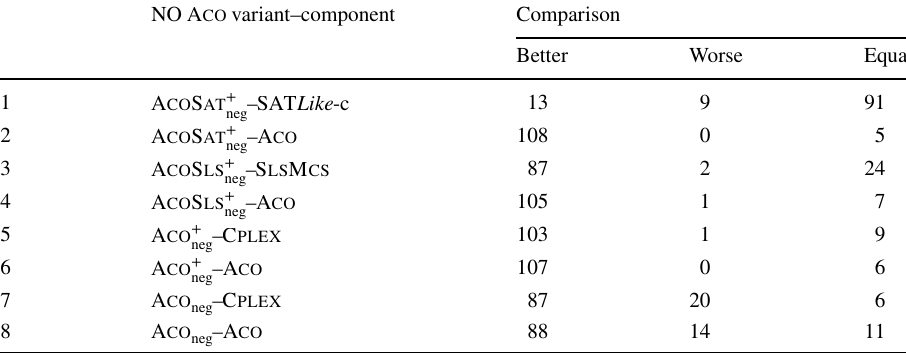
performance of our negative learning A CO variants with their individual algorithmic